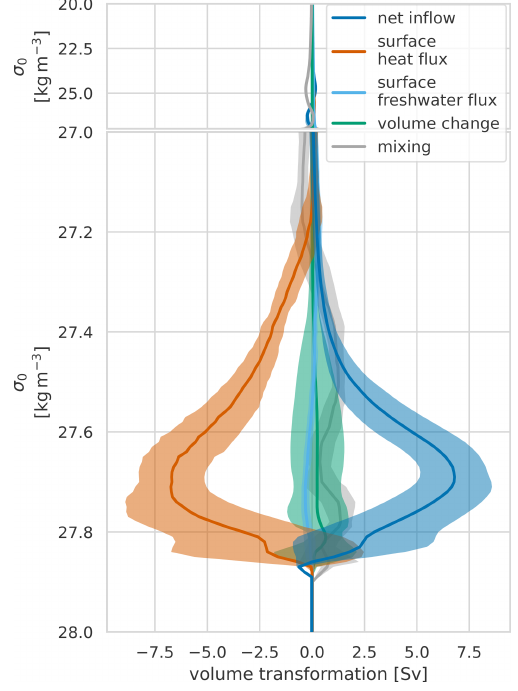
Figure 12. VIKING20X Labrador Sea mean water mass balance. Positive values of volume transformation are transformations across the isopycnal towards lighter densities. Net production of water of a particular density is therefore shown as negative gradients and net removal as positive gradients (i.e. surface heat flux acts to remove lighter waters by cooling – positive gradients, producing denser wa- ters – negative gradients). The primary balance is between net in- flow of lighter water and conversion to denser water by surface heat flux. Solid lines are average annual mean transformations, 1990– 2019; the shaded area shows ± 1 standard deviation in the annual